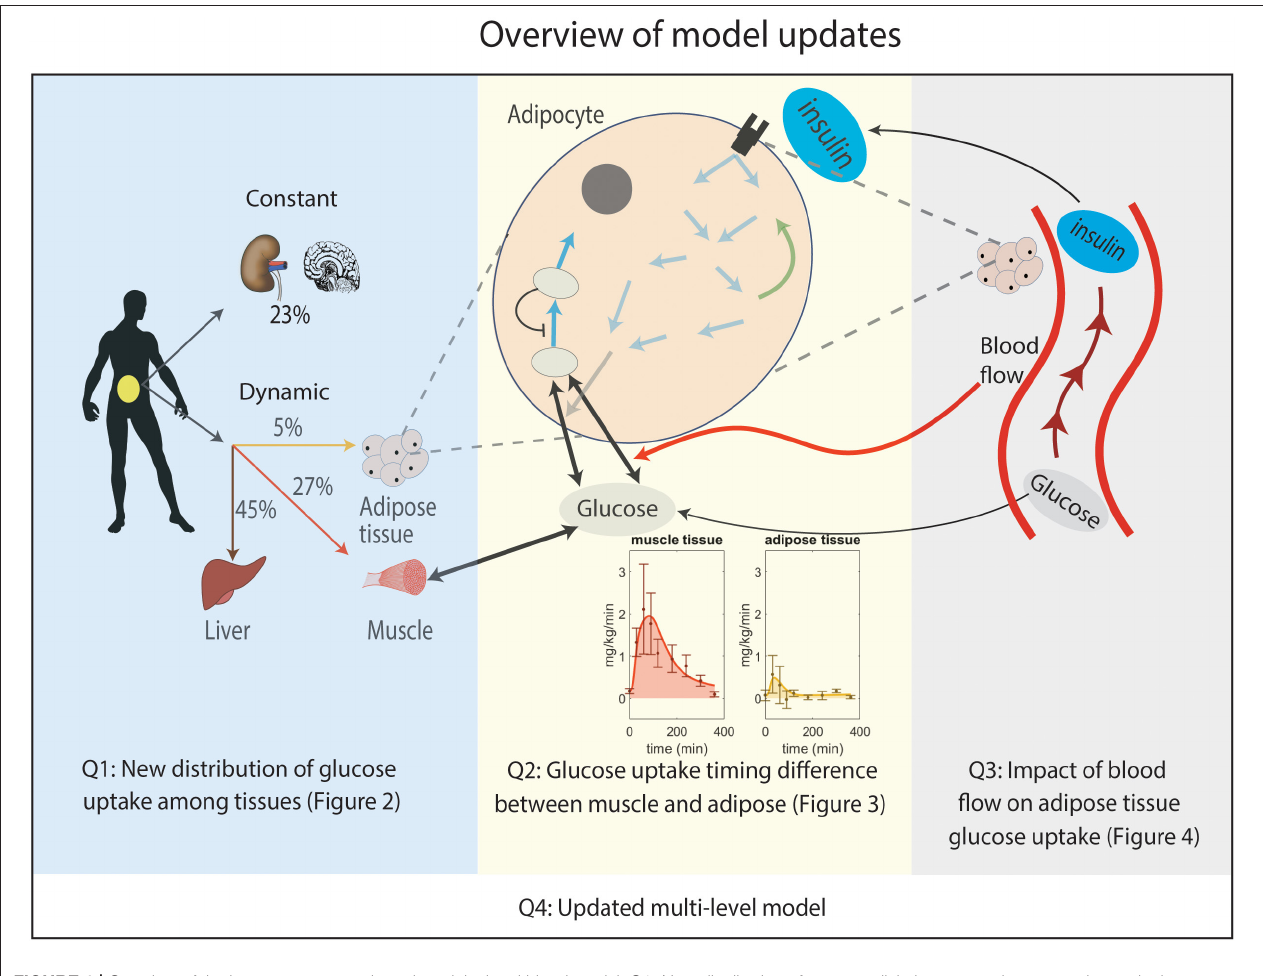
FIGURE 1 | Overview of the improvements made to the original multi-level model. Q1: New distribution of postprandial glucose uptake among tissues in the whole-body level model. Q2: Implemented timing difference in glucose uptake between muscle and adipose tissue by adding phosphorylation of intracellular glucose in the adipocyte module for glucose uptake (non-shaded arrows in adipocyte, see Supplementary Figure 1 for details). Note that the addition of a detailed myocyte module is not needed to explain the considered data. Q3: Inclusion of the impact of blood flow on glucose uptake in adipose tissue. Q4: Merging Q1, Q2, and Q3 boxes together gives an updated multi-level metabolic